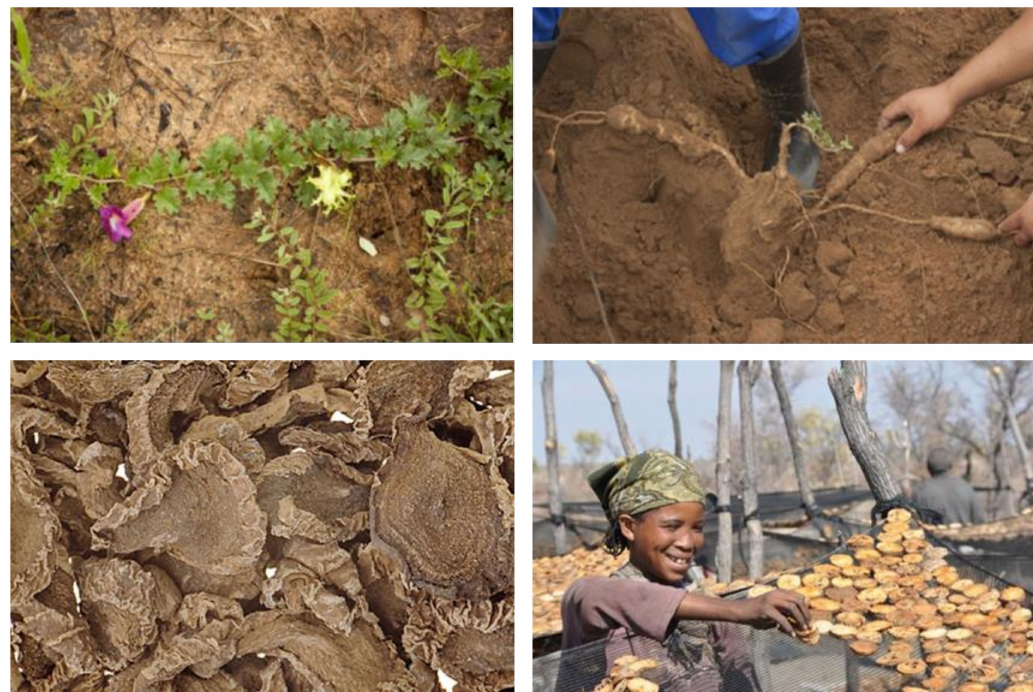
Figure 8. Clockwise: H. procumbens , secondary tubers, drying of the sliced tubers, article of commerce (photographs by the author). The article of commerce shown here is conventional quality (see Section 6). Note the difference in color of the slices shown on the bottom right, which were harvested and processed in compliance with